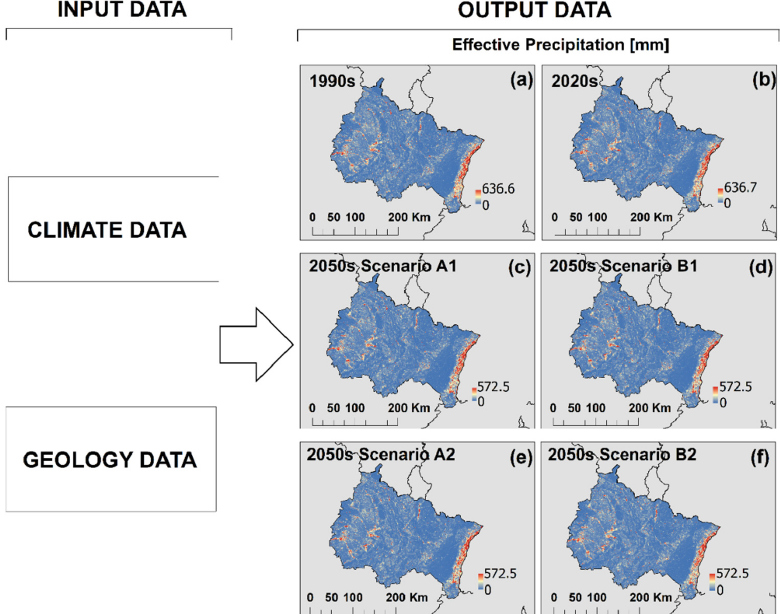
Figure 5. Spatial distribution of effective precipitation in the Grand Est region. ( a )